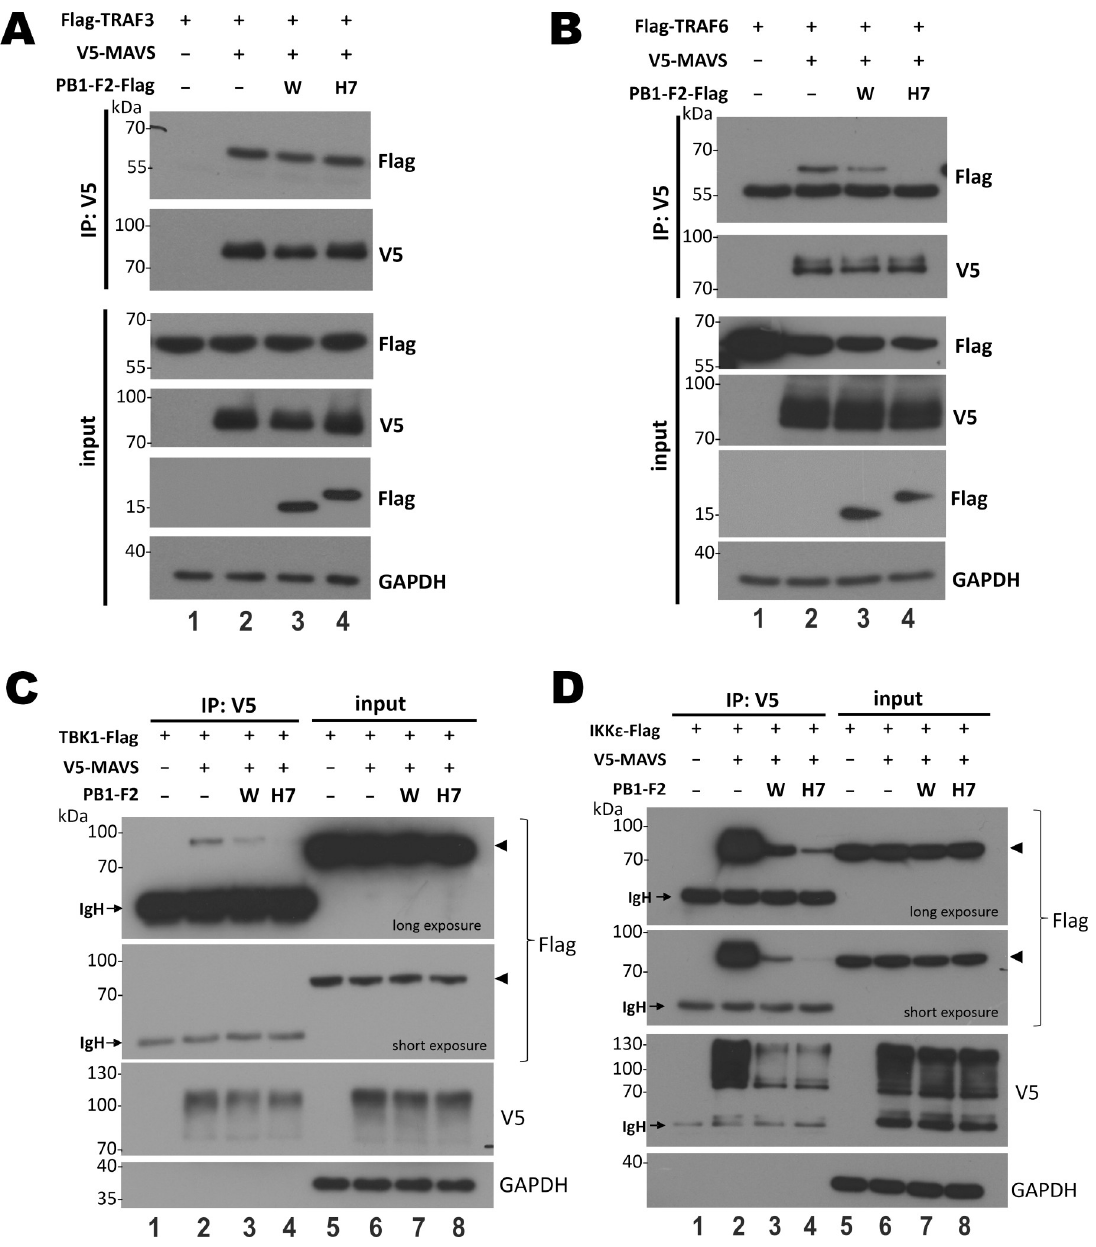
Fig 8. Interaction of MAVS with TRAF3 but not TRAF6-TBK1-IKK ε signalosome in the presence of H7N9 PB1-F2. HEK293T cells in 60mm dishes were co-transfected with 0.5 μ g pCAGEN-V5-MAVS, 0.25 μ g PB1-F2 expression construct and 0.5 μ g expression construct for Flag-TRAF3 ( A ), Flag-TRAF6 ( B ), Flag-TBK1 ( C ) or Flag-IKK ε ( D ). After 48 hours, cells were harvested for co- immunoprecipitation with anti-V5 (IP: V5). Both input and immunoprecipitates were analyzed by SDS-PAGE and Western blot analysis with anti-V5 for MAVS, anti-Flag for TRAF3 (A), TRAF6 (B), TBK1 (C) and IKK ε (D). GAPDH served as loading control. Arrowheads point to the target TBK1-Flag and IKK ε -Flag bands. IgH: immunoglobulin heavy chain. Three independent experiments were carried out and similar results were